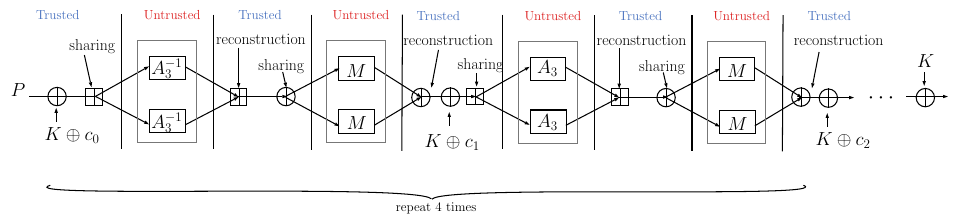
Figure 13: General idea of the Trojan-resilient implementation. To reduce the trusted area, the key additions can be performed in a shared manner. To reach better performance, one can compute the A function in the trusted 3